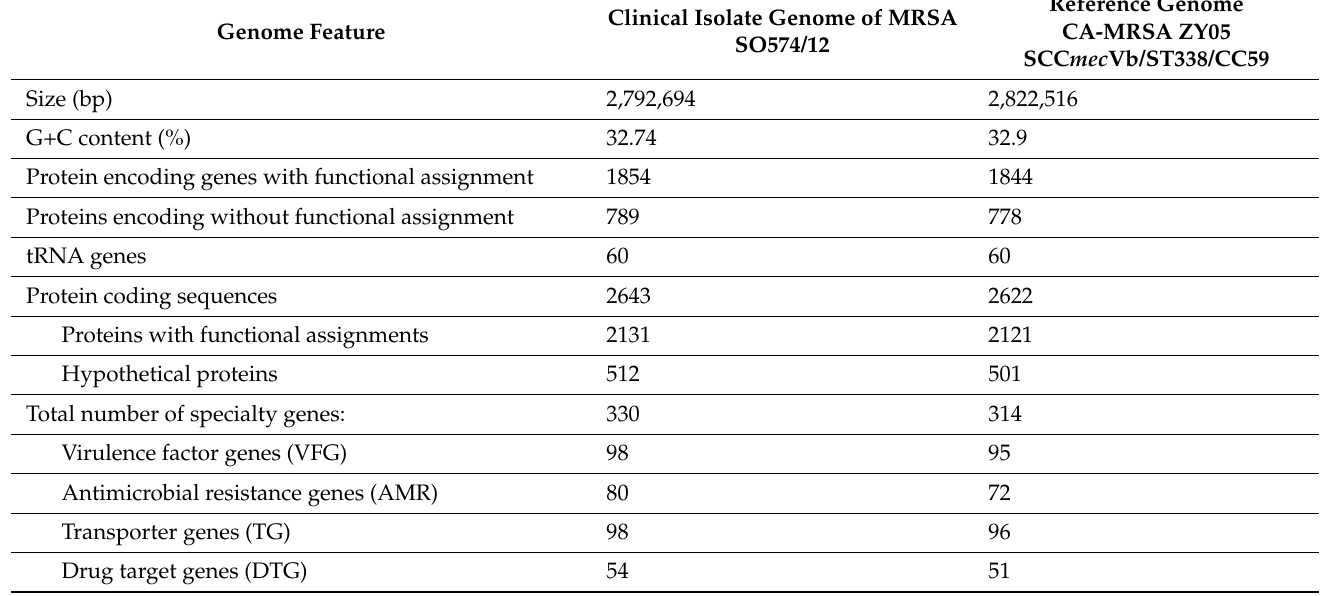
Table 4. General genome and protein features of the MRSA SO574/12 and reference CA-MRSA